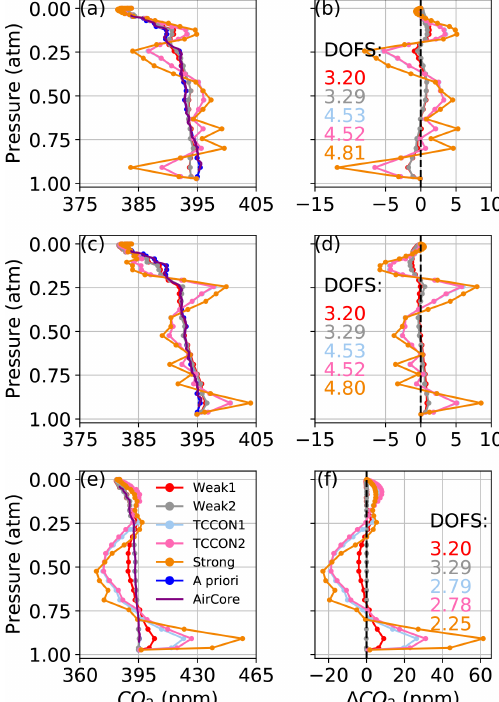
Figure 6. The left-hand panels show CO 2 profiles retrieved using synthetic spectra for (a) + 5 ◦ C added to the a priori temperature profile below 5km, (c) + 2 ◦ C between 8 and 13km, and (e) + 2 ◦ C above 15km. Panels (b) , (d) , and (f) show the difference between the retrieved profiles and AirCore profile, corresponding to (a) , (c) , and (e) respectively. Note the difference in the horizontal axis range between the panels. Here 5km corresponds to ∼ 0.55atm, 8–13km to ∼ 0.36–0.17atm and 15km to ∼ 0.125atm.